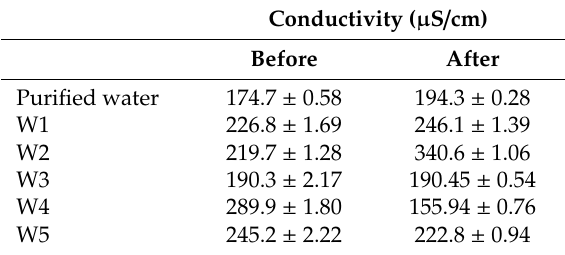
Table 3. Conductivity values before and after the